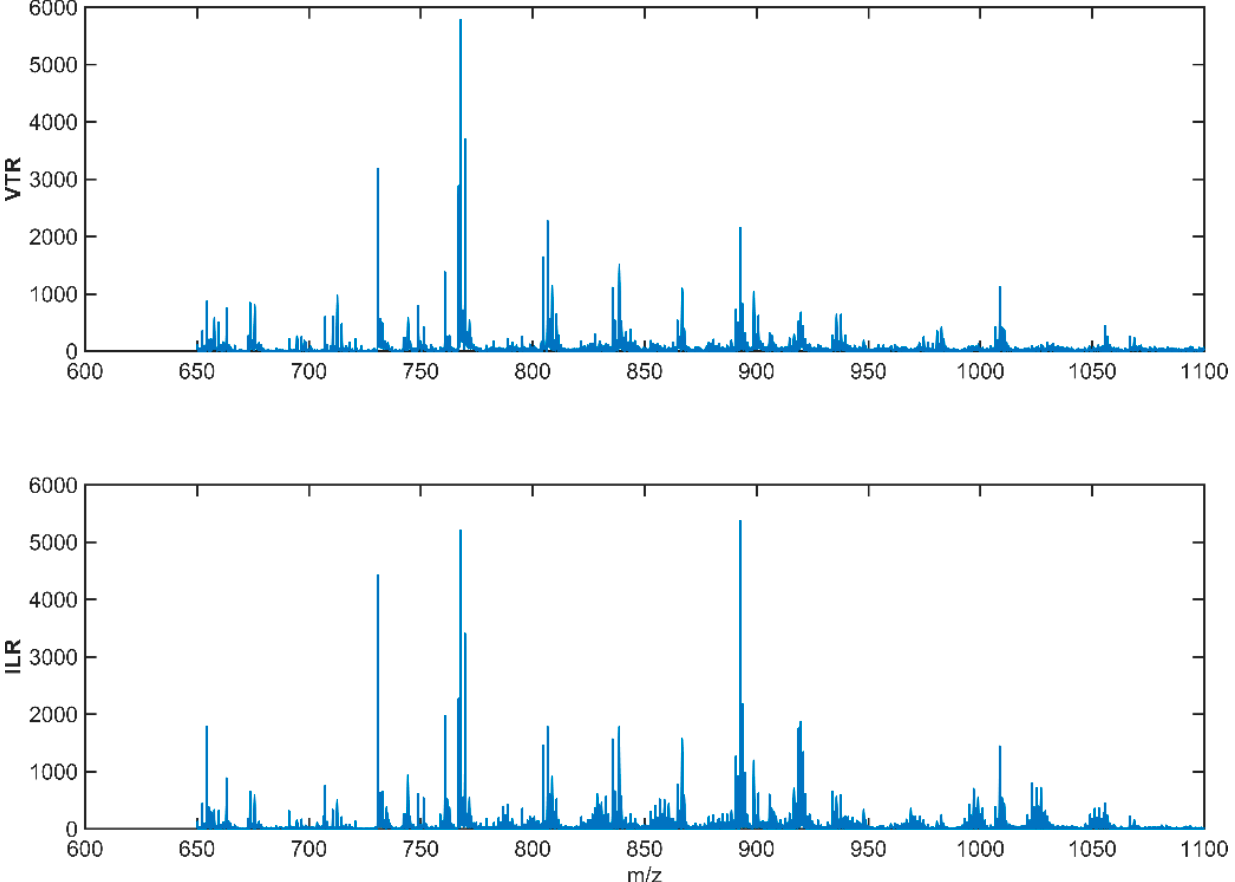
Figure 3. Normalized, baseline-corrected, smoothed, and aligned spectra of two milk tank samples: Valtierra (VTR) tank sample above and Ilarregi (ILR) tank sample below. These spectra have been obtained in a range of 600–2000 Da mass range in positive ionization mode (MS + ) using a Bruker Autoflex mass spectrometer fitted with a MALDI source.